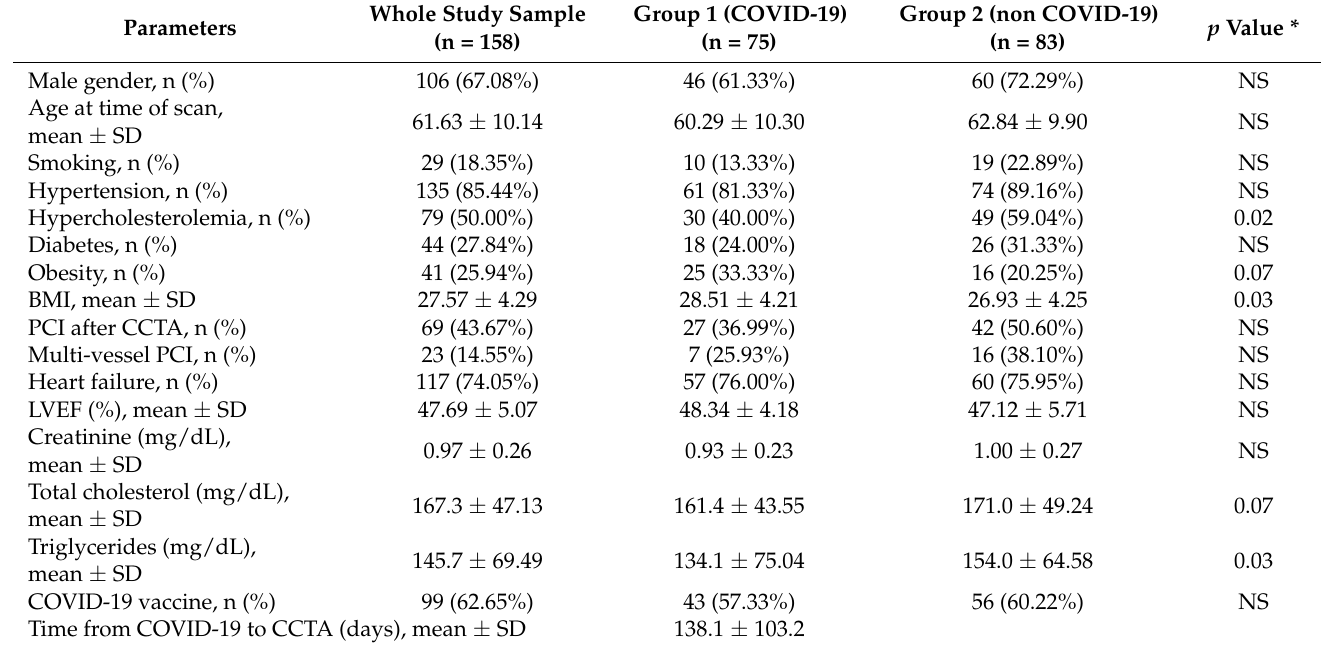
Table 1. Baseline characteristics, comorbidities, and risk factors in the study